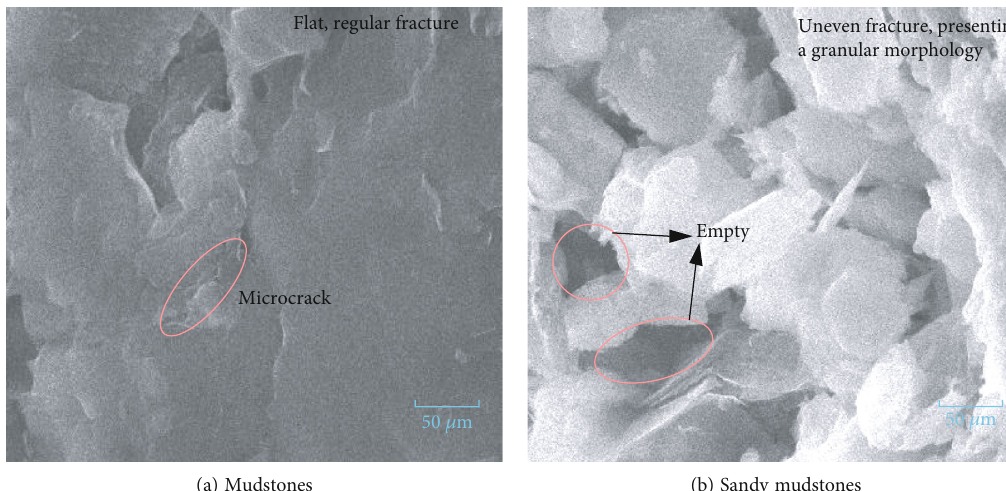
Figure 3: SEM patterns of crushed rock masses.